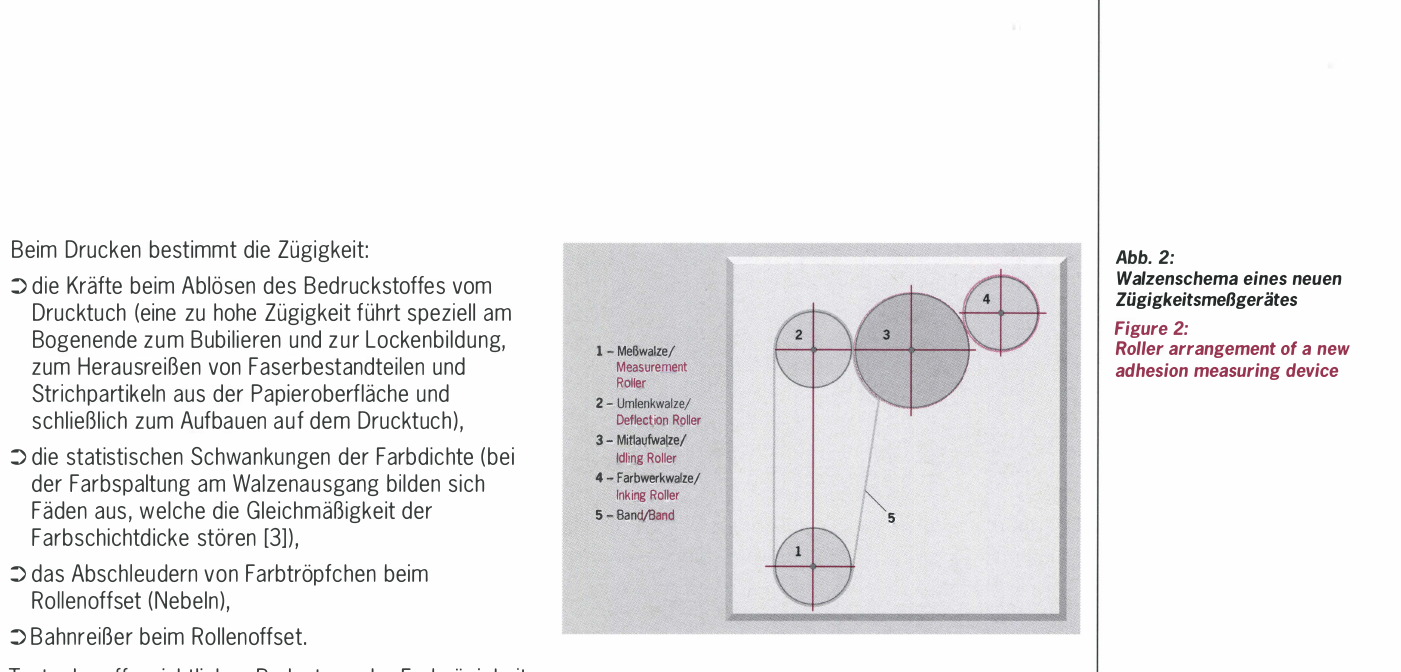
Figure 2: Roller arrangement of a new adhesion measuring